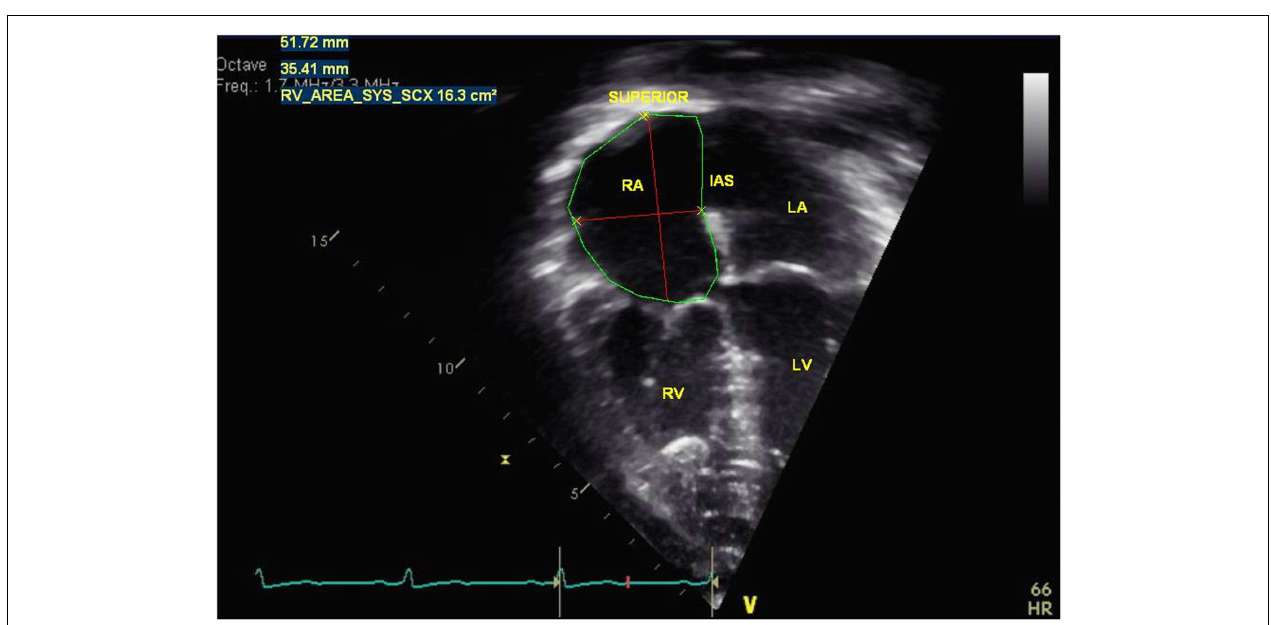
FIGURE 1 | Measurement of right atria dimensions (major and minor axis) and right atrial area in end-systole in a pulmonary hypertension patient . RA = right atria, RV = right ventricle, IAS = interatrial septum, LA = left atria, LV = left ventricle.